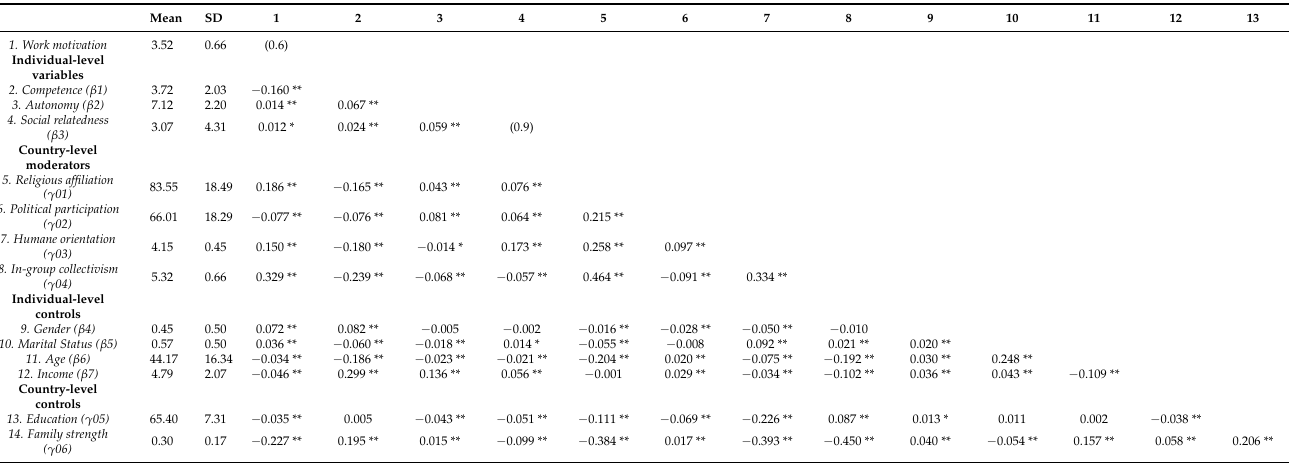
Table 2. Descriptive statistics, cross-level correlations and scale reliability a,b,c .